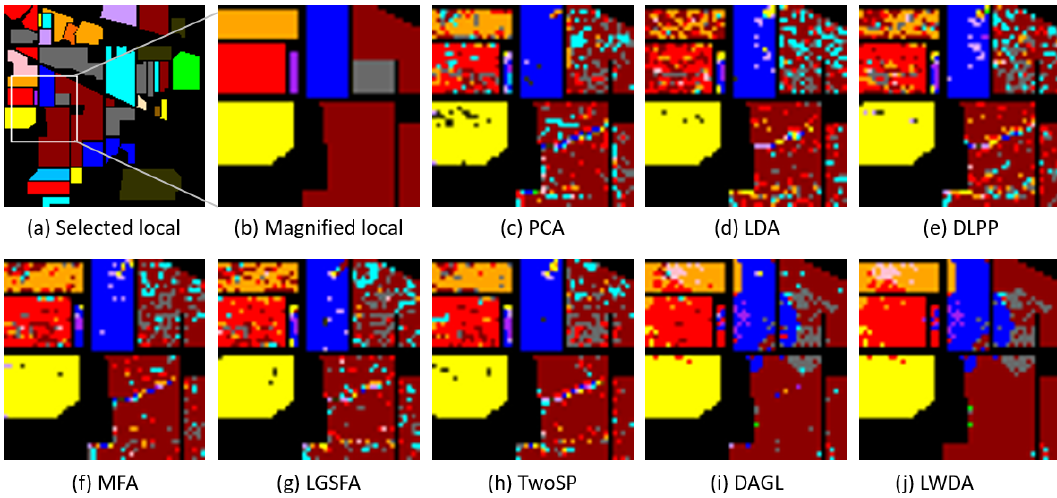
Figure 3. Local magnification (with a magnification factor of 3) of the output classification maps shown in Figure 2. ( a ) Selected local region; ( b ) magnified local region; ( c ) PCA; ( d ) LDA; ( e ) DLPP; ( f ) MFA; ( g ) LGSFA; ( h ) TwoSP; ( i ) DAGL; ( j ) proposed